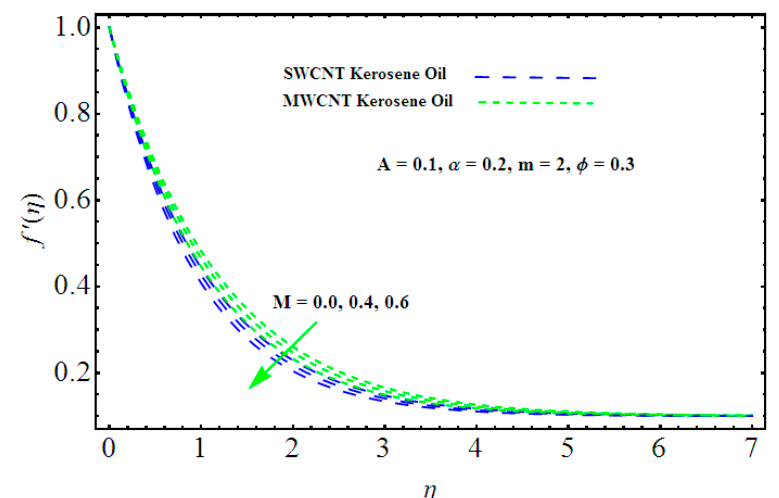
Figure 6. Impact of M on velocity f (cid:48) ( η ) .